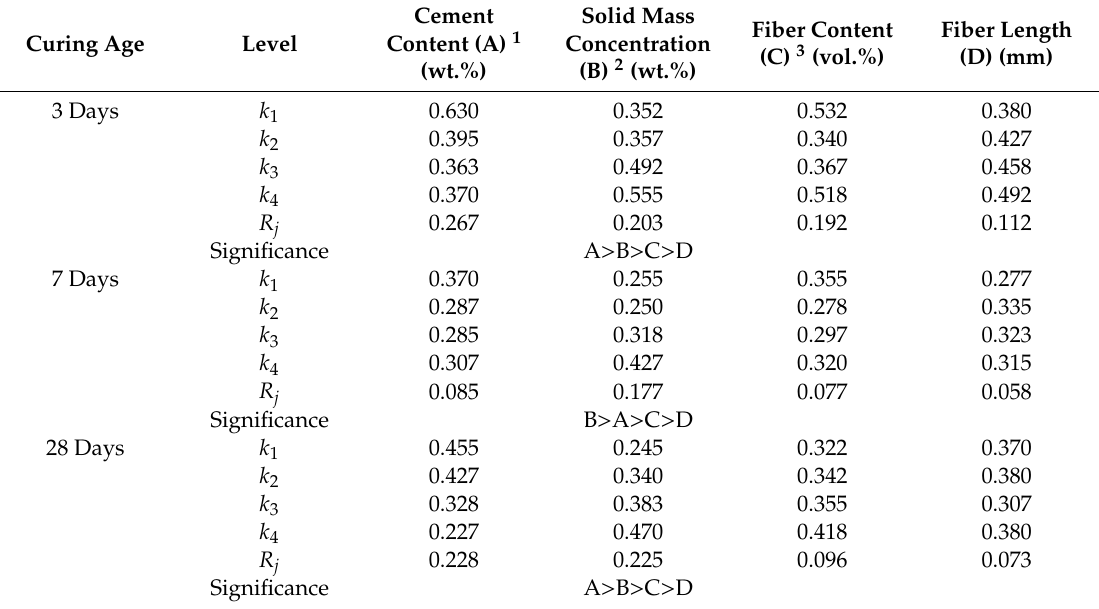
Table 3. Orthogonal analysis of ranges of the UCS of CPB